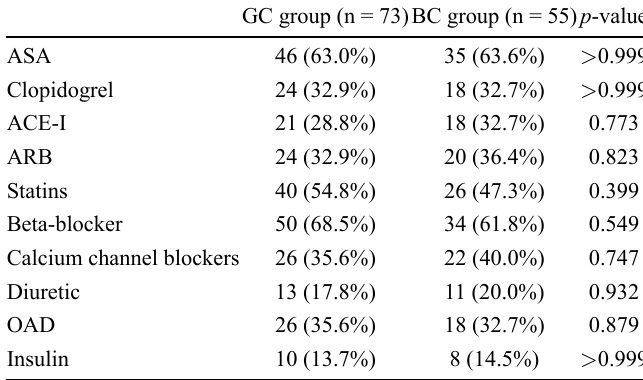
Table 3. Distribution of medications used by patients in the good collateral (GC) and bad collateral (BC)